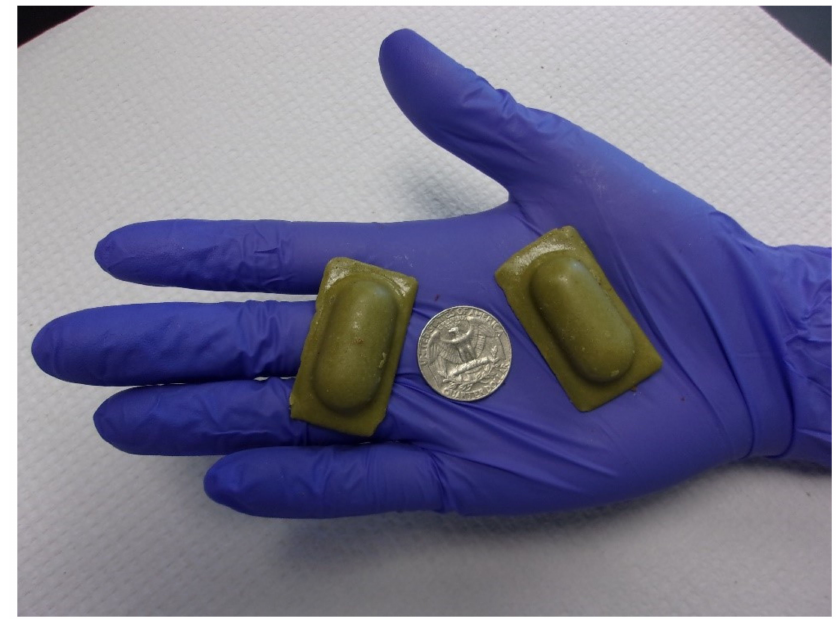
Figure 1. Ultralite ORV baits coated with external bait